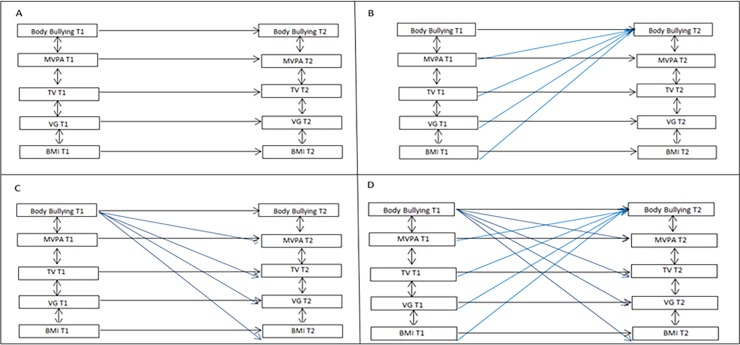
Structural equation modeling results and estimates (standardized) between HRBS and body bullying for boys/girls.*** p < .001, ** p < .01, * p < .05. Boys N = 436 and girls N = 374. All models were adjusted by socioeconomic information and psychological well-being- omitted in the Fig 2.